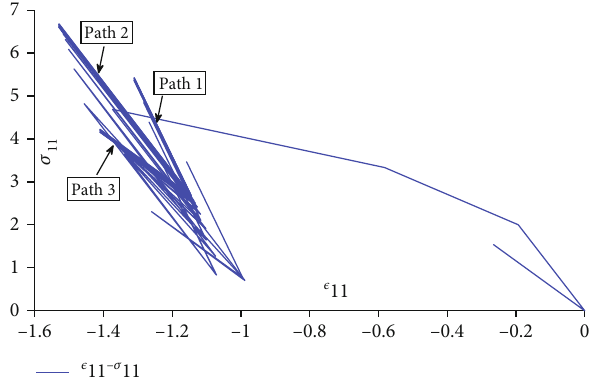
− σ ) under 3 critical loads 11 11